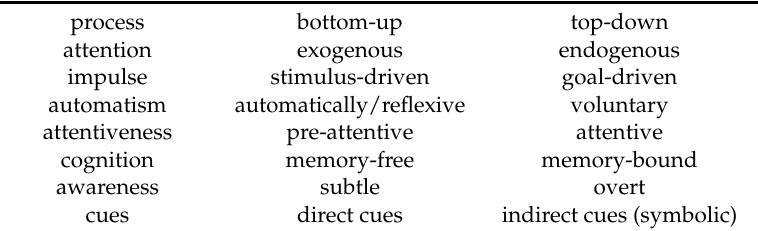
Table 1. Attributes of attention-guiding techniques used in